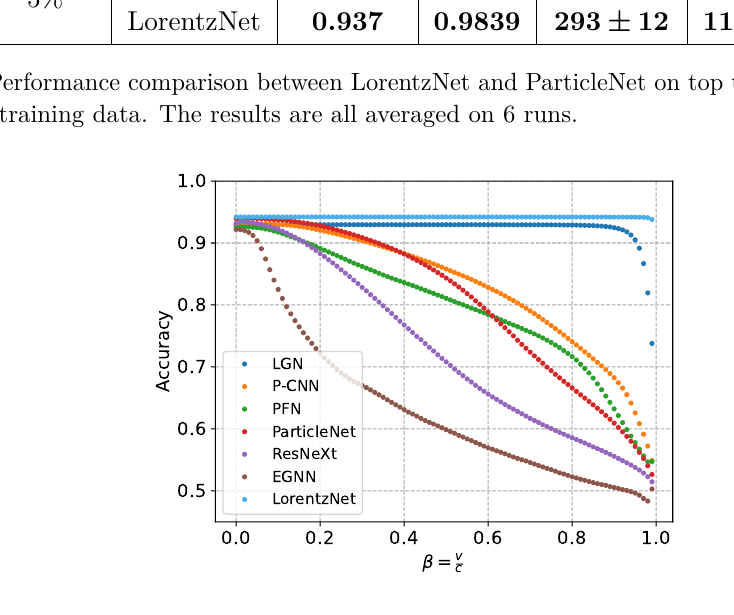
Figure 3 . Equivariant test under Lorentz boosts on top tagging